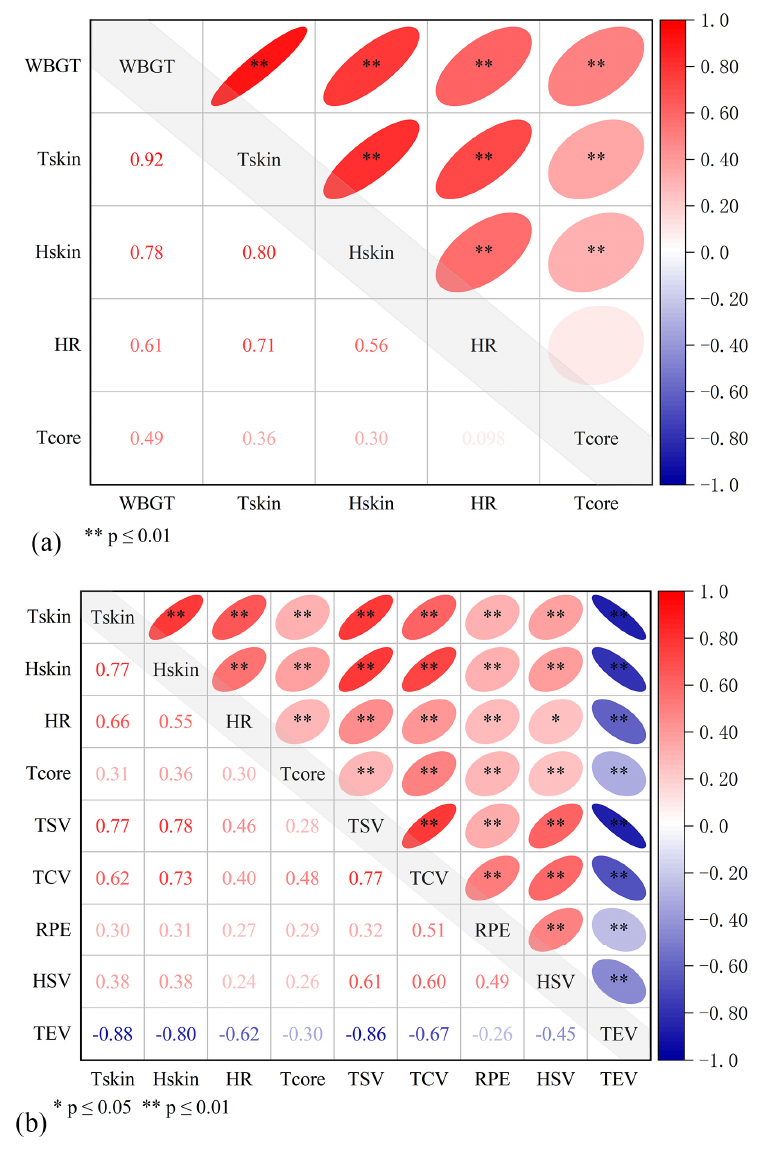
Figure 8. Correlation between physiological parameters and WBGT (or perceptual responses). ( a ) Correlation heatmap of physiological parameters and WBGT. ( b ) Pearson correlation analysis between subjective evaluation and physiological